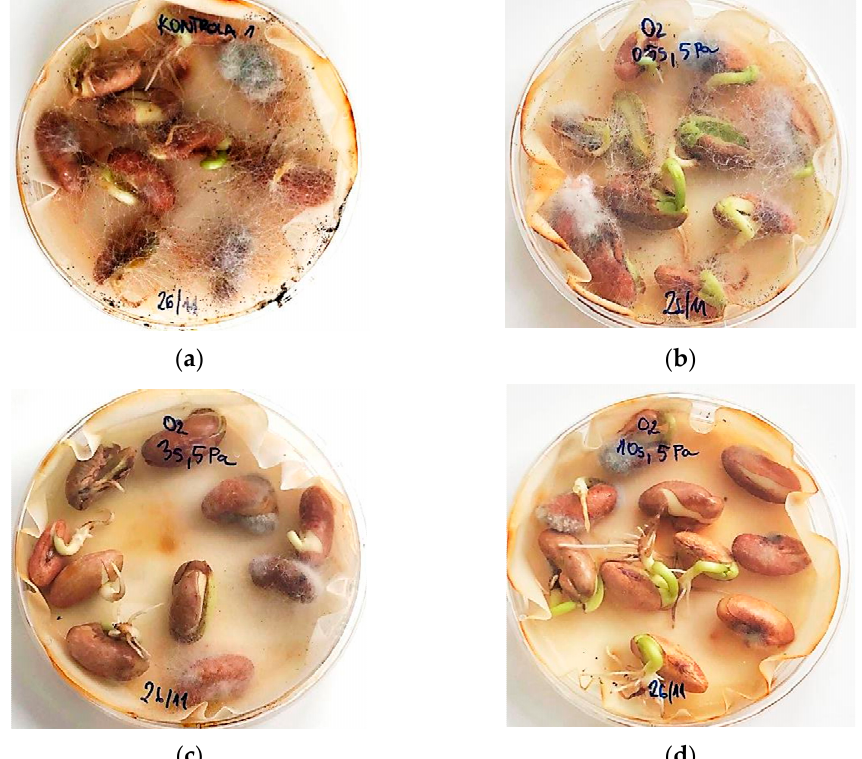
Figure 12. Bean seeds incubated at germination conditions after 7 days. Sprout and root growth are visible, as well as the presence of fungal contamination. ( a ) Untreated; ( b ) p = 5 Pa, t = 0.5 s; ( c ) p = 5 Pa, t = 3 s; ( d ) p = 5 Pa, t = 10 s.